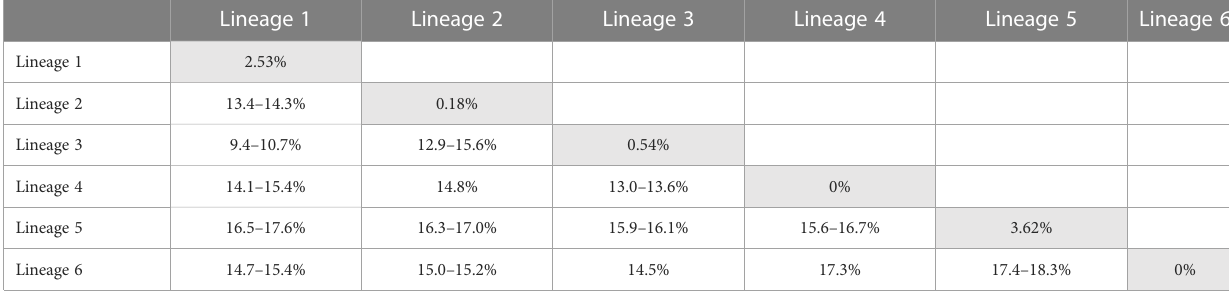
TABLE 1 Intra- (gray) and inter-lineage p -distances of Caulacanthus calculated using the COI-5P gene.